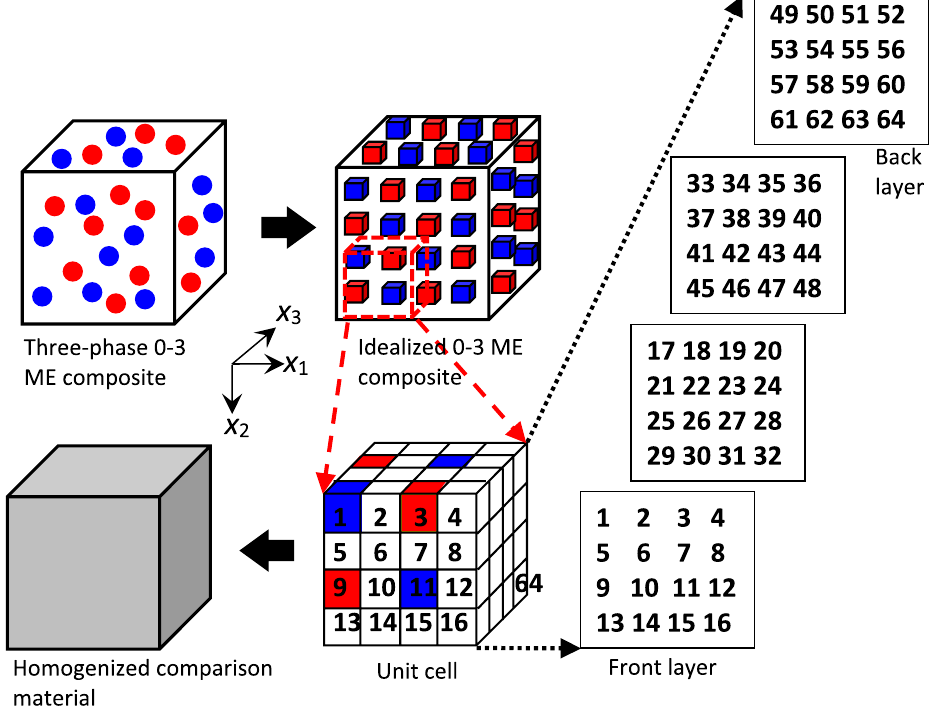
Figure 1. Homogenization process of the simplified unit-cell micromechanics model for a three-phase 0–3 ME composite. ME an abbreviation for